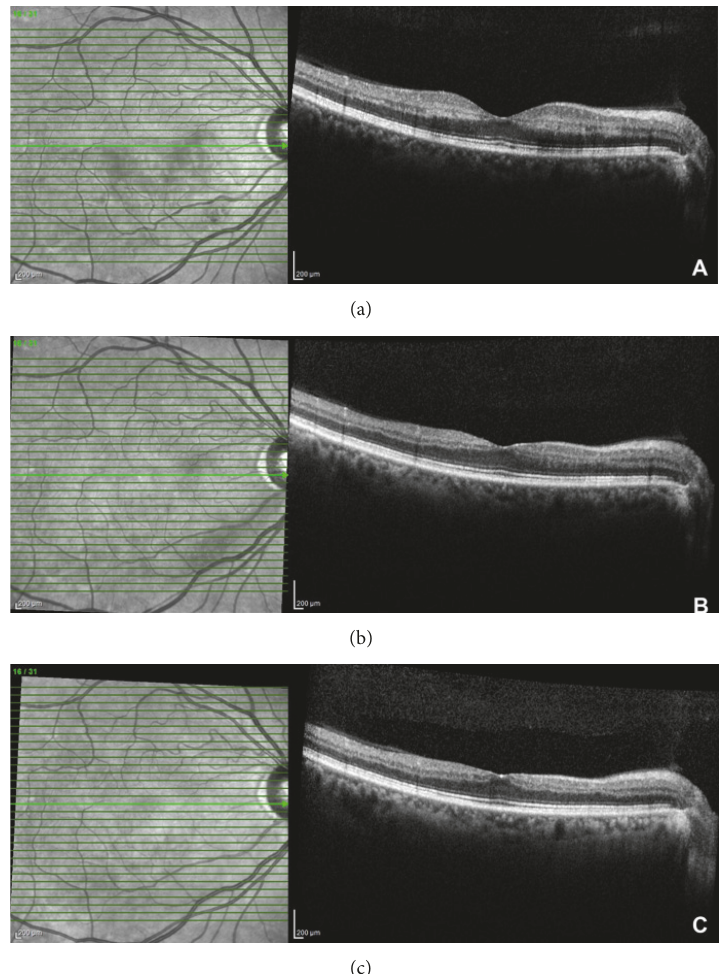
Figure 2: Optical coherence tomography showing acute inner retinal thickening and hyperreflectivity at the patient’s initial presentation (a). Optical coherence tomography showing very mild thinning and atrophy of the inner retinal layers two and a half months (b) and six months after her initial presentation